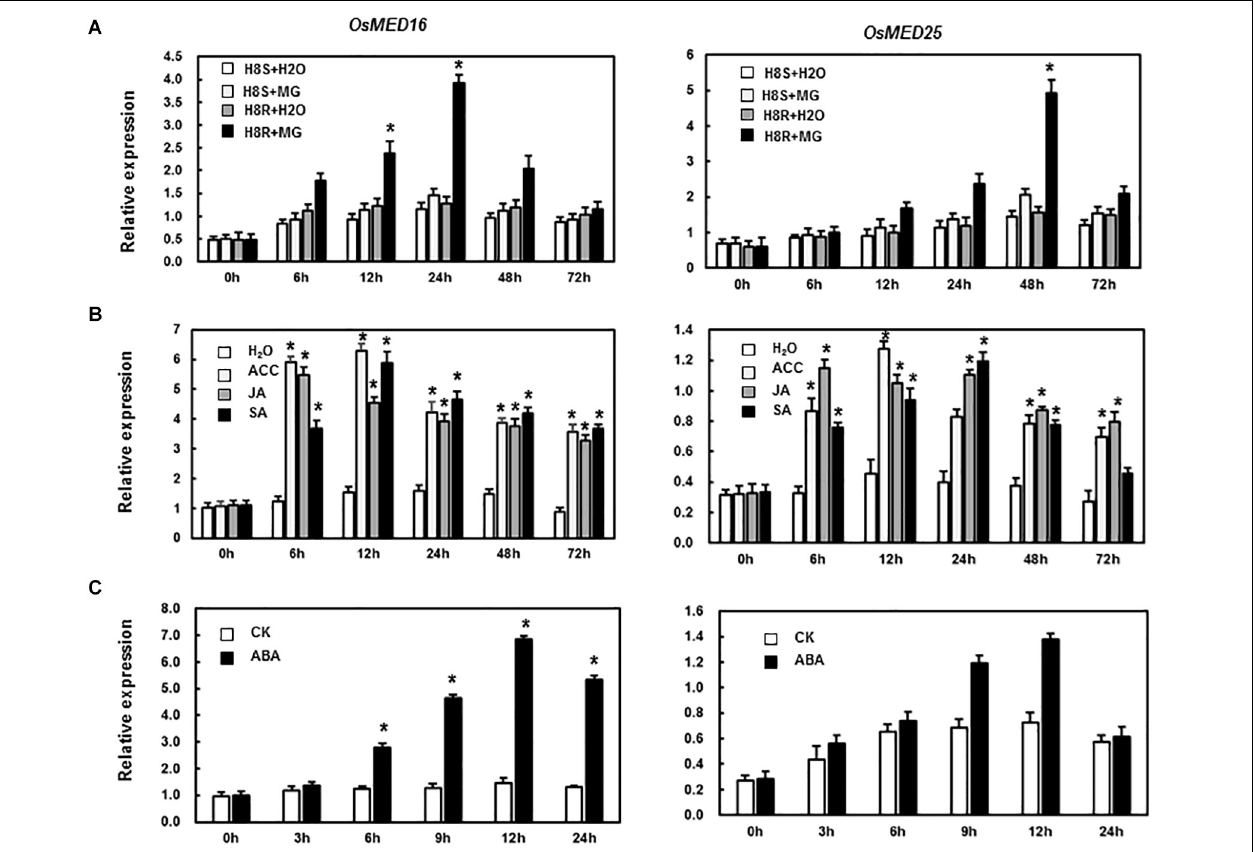
FIGURE 2 | Expression patterns of OsMED16 and OsMED25 genes in response to Magnaporthe grisea infection and hormone treatment. (A) The expression patterns of OsMED16 and OsMED25 following inoculation with M. grisea. (B) The expression patterns of OsMED16 and OsMED25 following treatment with 1.5 mM SA, 100 µ M JA, and 100 µ M ACC. (C) The expression patterns of OsMED16 and OsMED25 following treatment with 100 µ M ABA. The data were normalized against OsActin gene, and the relative expression was shown as fold expression of OsActin . Data are presented as means ± SD from three independent experiments and * above the columns indicate significant differences at p < 0.05 between the pathogen-inoculated or hormone-treated plants and the mock-inoculated/treated plants.